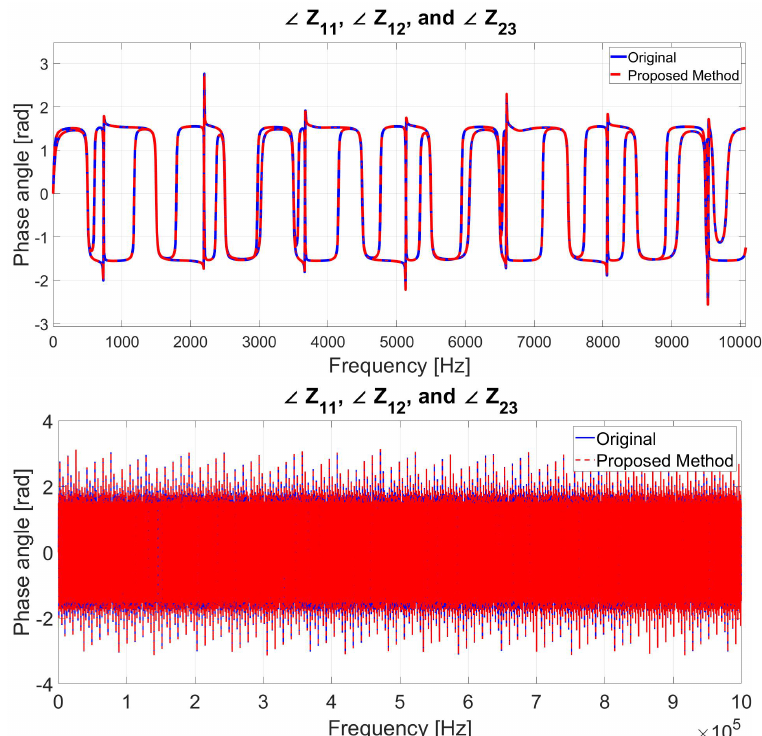
Figure 26. The angle of the measured and fitted impedance using the proposed model, ∠ Z 11 , ∠ Z 12 , and ∠ Z 23 .